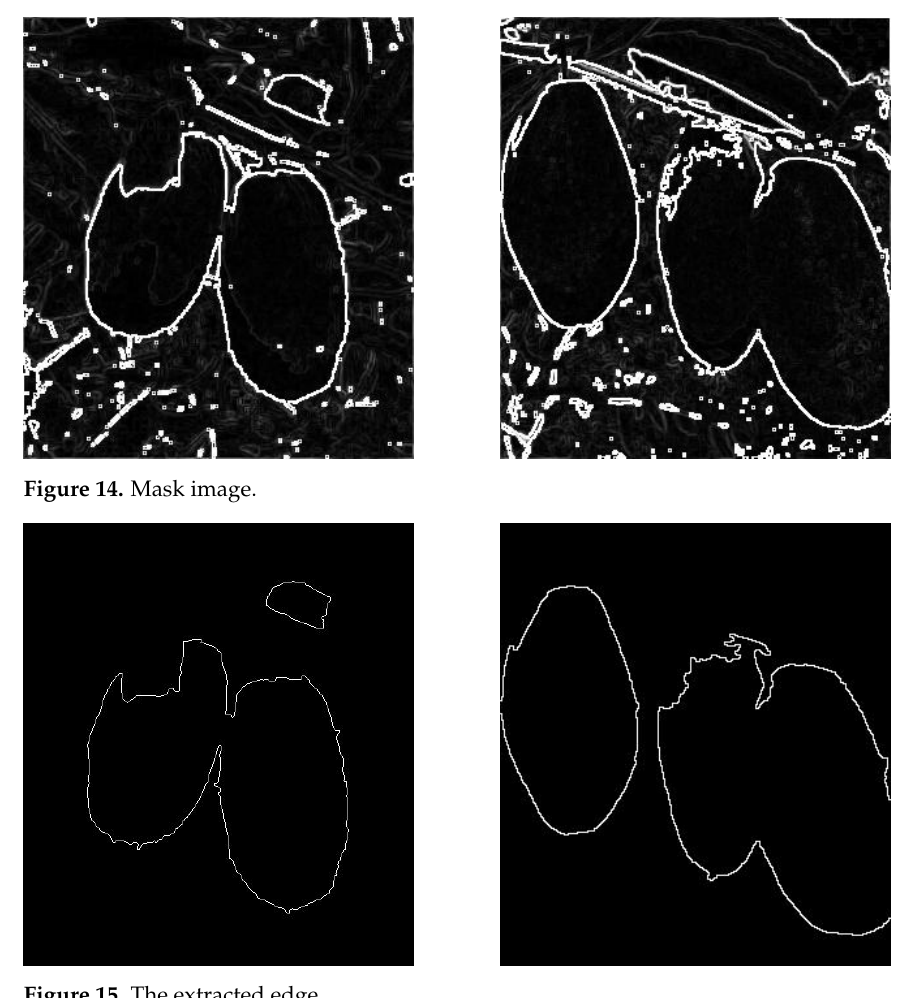
Figure 15. The extracted edge.